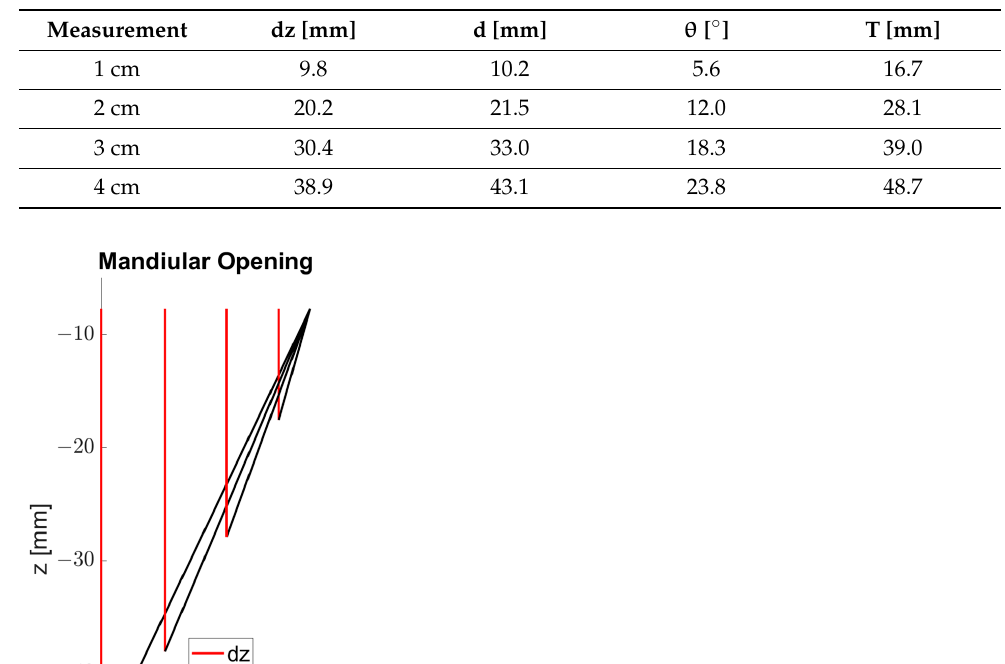
Table 1. Parameters calculated with the collected data.